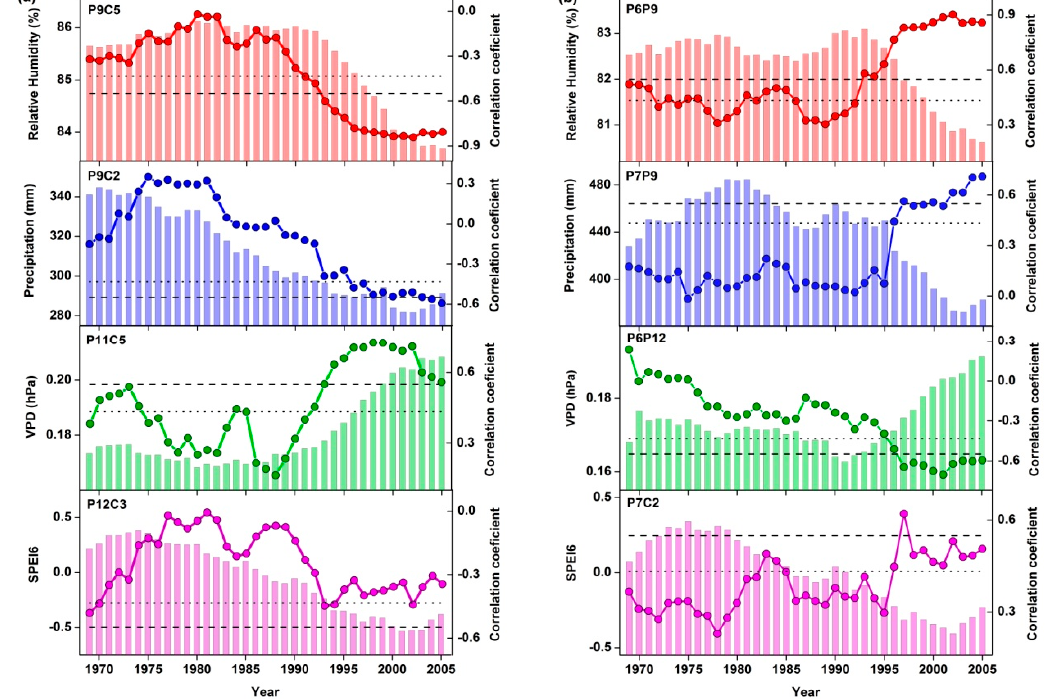
Figure 6. Running correlation analyses for δ 13 C-climate and tree growth–climate relationships. X-axis indicated the center of the 21-year moving window. Bars show the mean value of the climatic variables for each window. Lines with dotted symbol show the corresponding correlation coefficient. Dotted and dashed horizontal lines indicate significance levels at 95% and 99%, respectively. ( a ) 21-